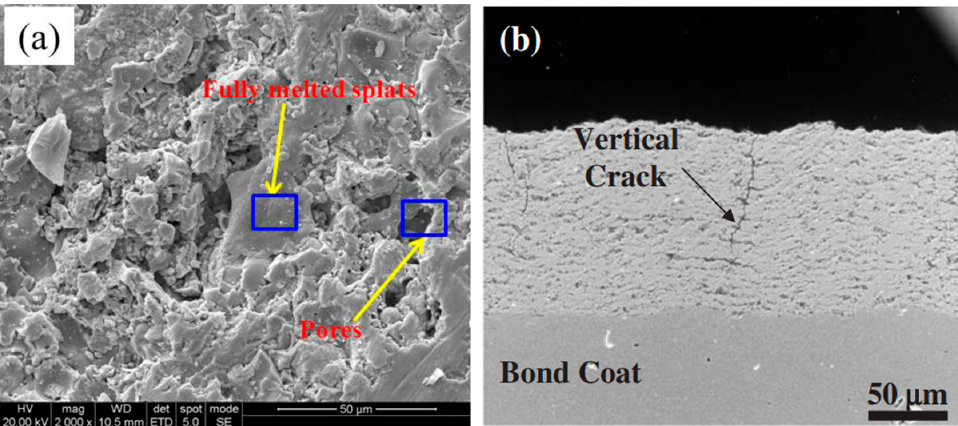
Figure 15. The SPPS TBCs have unique microstructural characteristics: ( a ) small splat area, and ( b ) stress reduced by introducing vertical cracks inside the coating [64,65].